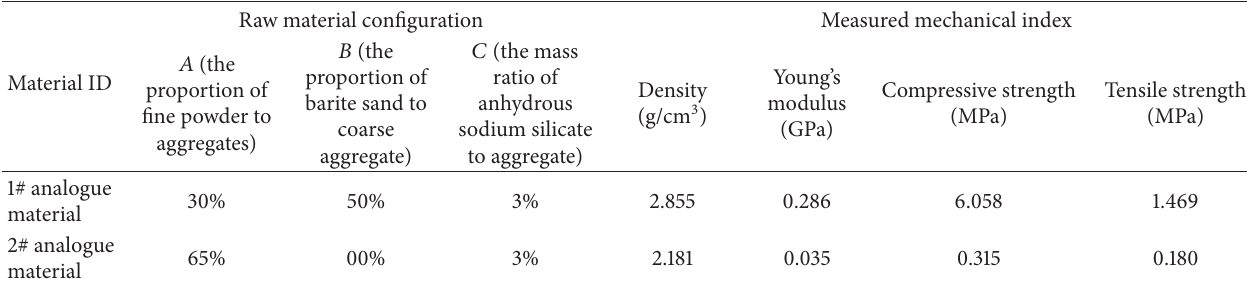
Table 12: Raw material configurations and the measured mechanical indices of analogue